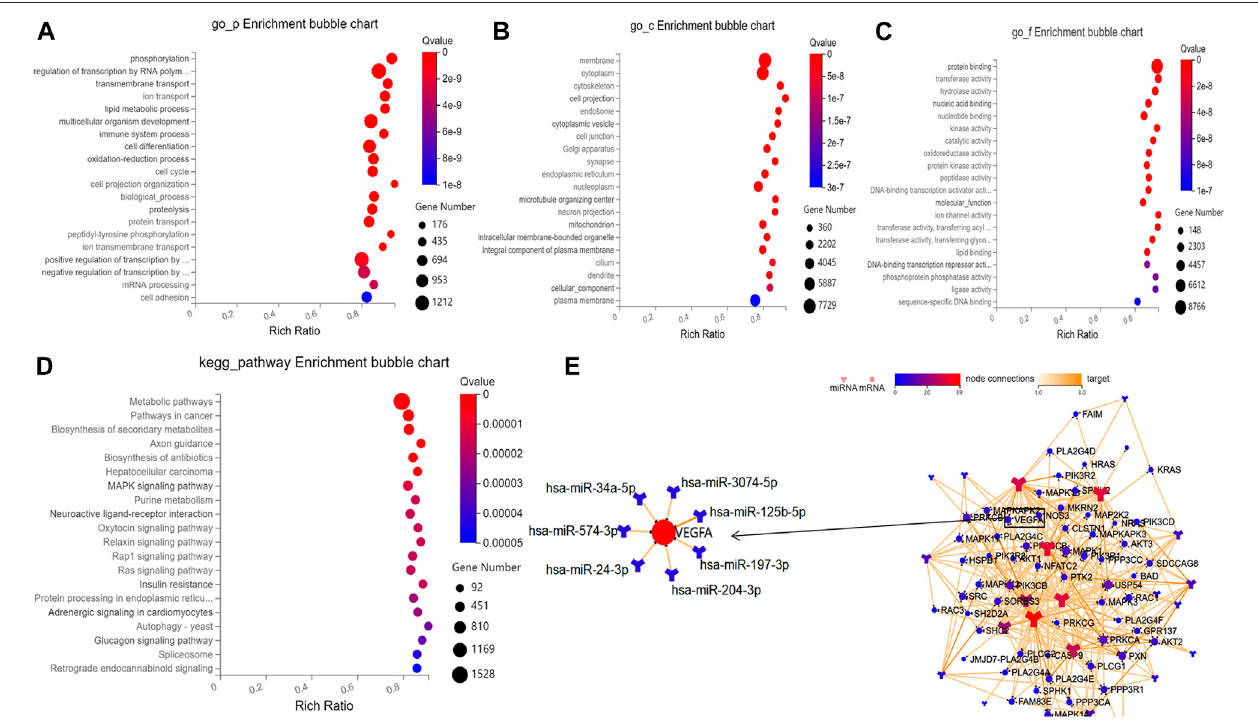
FIGURE 3 | Results of bioinformatic analysis. (A – C) Bubble diagram respectively shows the top 20 GO enrichment annotations about biological process, cellular component, and molecular function of target mRNAs. (D) Bubble diagram exhibits the top 20 KEGG pathway analysis of target mRNAs. (E) The network illustrates the target relationship between the 29 a fl ibercept-induced miRNAs and mRNAs in VEGF signaling pathway, the specially marked parts of which show seven miRNAs that directly target VEGFA.